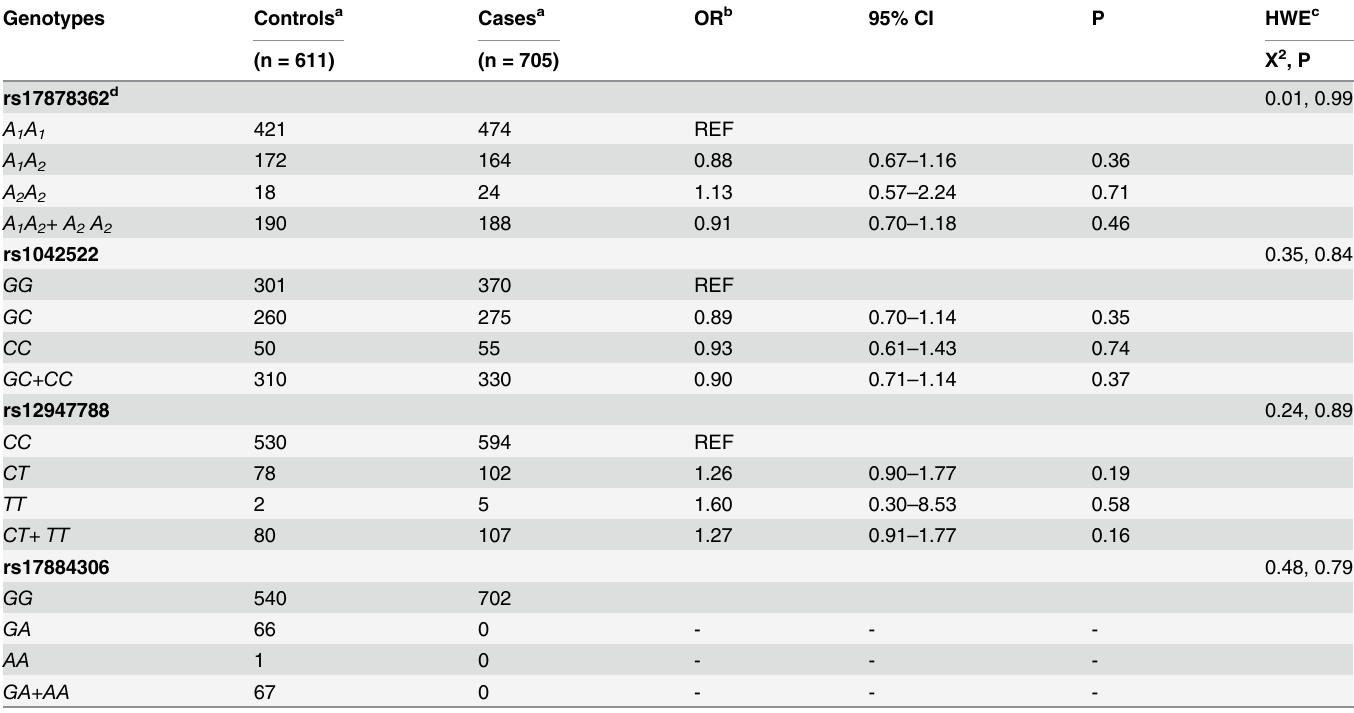
Table 1. Genotype distribution of investigated TP53 polymorphisms in BC patients and controls.